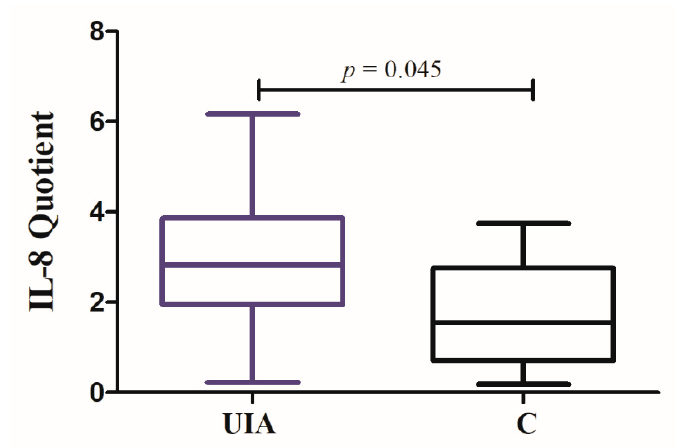
Figure 2. IL-8 Quotient in unruptured intracranial aneurysm (UIA) patients compared to control group (C).